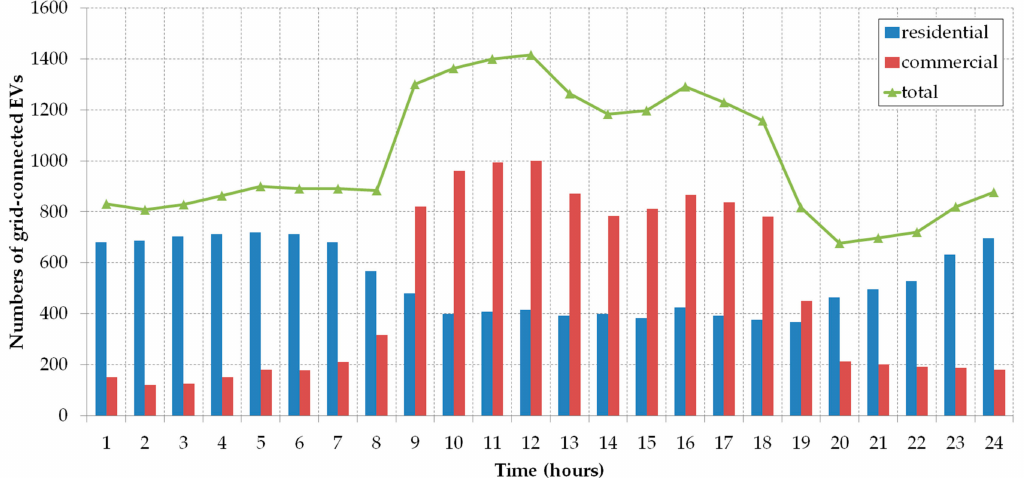
Figure 4. Electric Vehicle (EV) grid connection probability of the